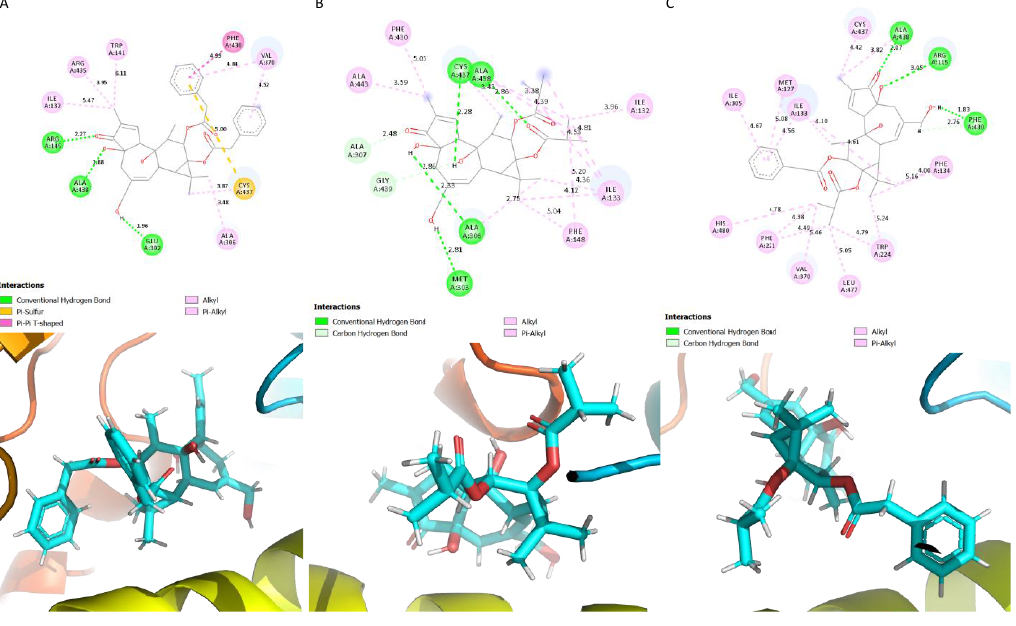
Figure 2. Schematic showing the protein ligand interactions ( A ) P-12,13-diAcPh, ( B ) P-12,13-diiBu and ( C ) P-12AcPh-13iBu. The ligands P-12Ang-13iBu, P-20Ac-12AcPh-13iBu and P-20Ac-12Ang-13iBu inter- acted with non-polar residues, bar the residue Cys 437 which is polar (Figure 3). The lig- and P-12Ang-13iBu formed a carbon – hydrogen interaction with the residues Ala 307 and Gly 439 (Figure 3A). Hydrogen bonds were also formed with Cys 437, Ala 438, Ala 306 and Met 303 (Figure 3A). Hydrogen bonds were formed with Ala 438, Cys 437 and Ala 306 and the phorbol diester P-20Ac-12AcPh-13iBu (Figure 3B). Ala 307 and Gly 439 formed carbon hydrogen interactions with the ligand; the rest of the interacting residues formed alkyl and pi-alkyl interactions (Figure 3B). Ala 307 and Gly 439 formed carbon hydrogen bonds with the ligand, Ala 438, Cys 437 and Ala 306 formed hydrogen bonds with the phorbol diester P-20Ac-12Ang-13iBu (Figure 3C).